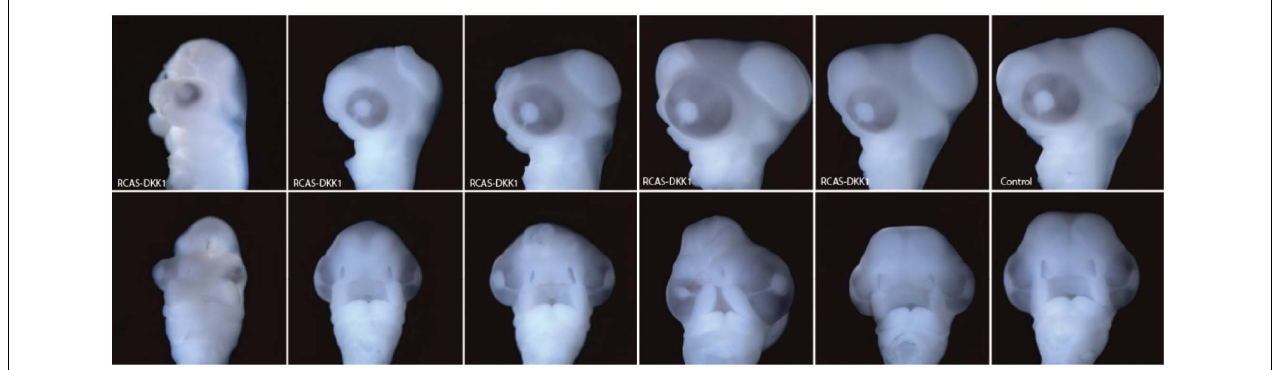
FIGURE 5 | Range of phenotypes observed in RCAS- Dkk1 at HH22. Top row: lateral view. Bottom row: anterior view. Typical control on far right.